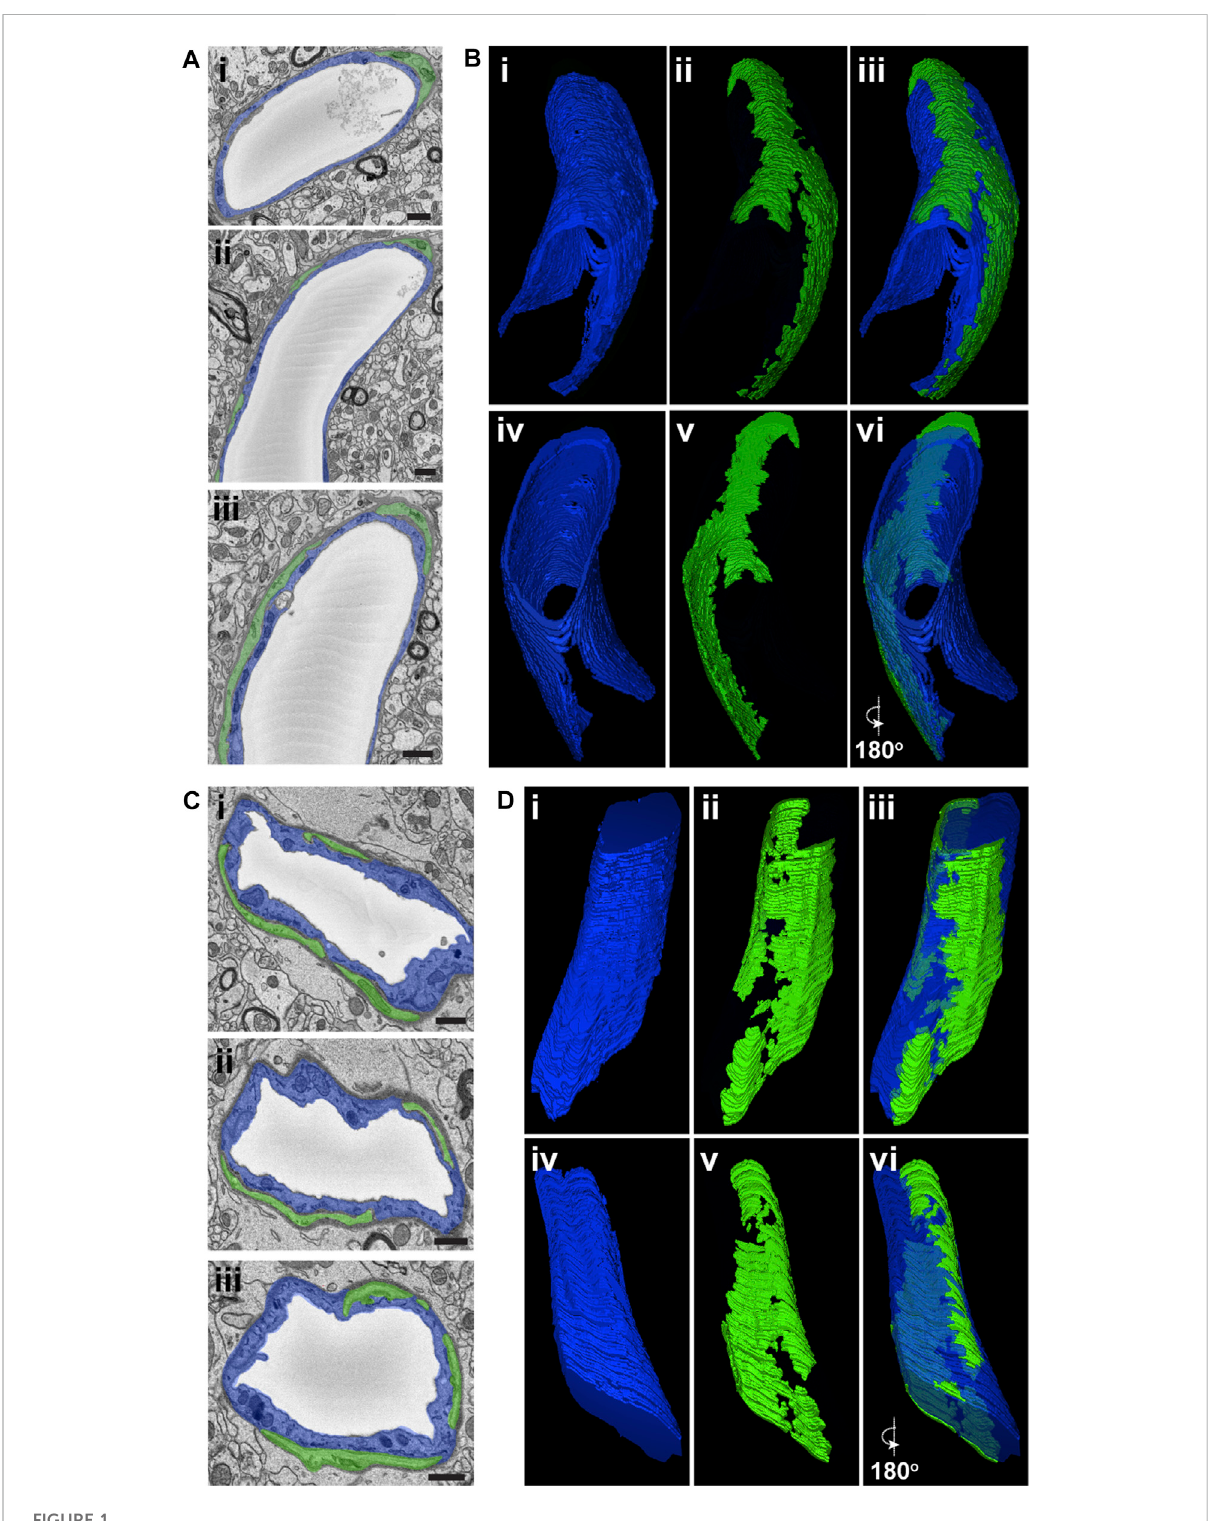
Representative SEM Images and 3D Renderings of Thin-Strand and Mesh Pericytes in Mouse Brain Microvessels. (A) SEM images of an EC (pseudo-colored blue ini, ii,and iii) and thin-strand PC (pseudo-colored green in i,ii, and iii) within the wall of amouse brain microvessel.Scale bars, 1 μ m. (B) 3D renderings of an EC (blue in i,iii, iv, and vi) and a thin-strandPC (green in ii, iii, v, and vi) generated from annotated SBF-SEM datasets. To allow for a more complete view of the vessel, EC renderings have a reduced opacity, and images in iv, v, and vi are a 180-degree rotation